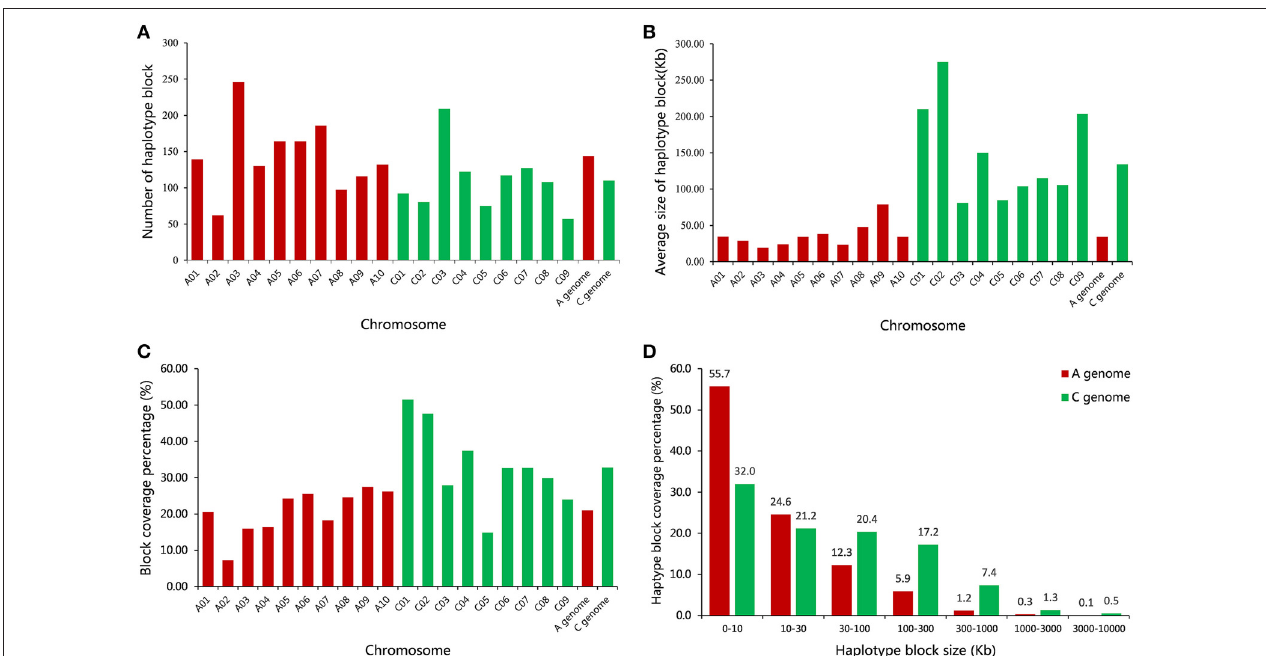
FIGURE 4 | Comparative analysis of haplotype block structure in the A-subgenome and C-subgenome of rapeseed. (A) A comparison of the number of haplotype blocks on 19 rapeseed chromosomes. (B) A comparison of the average size of haplotype blocks on 19 rapeseed chromosomes. (C) A comparison of the haplotype block coverage percentage on 19 rapeseed chromosomes. (D) A comparison of the haplotype block size range distributions on the A- and